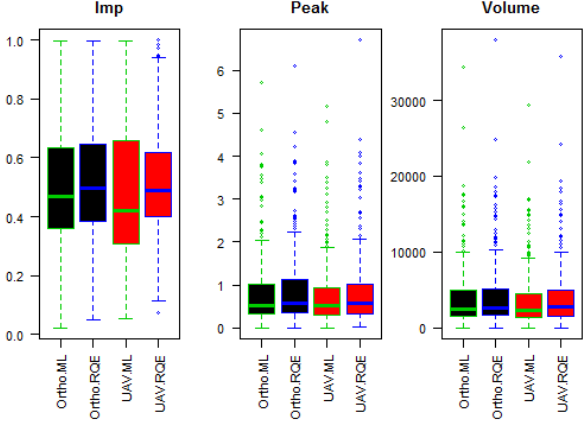
Figure 6. Boxplots of the imperviousness and surface runoff char- acteristics (Imp (–), Peak (Ls − 1 ), Volume (m 3 )) for the 307 sub- catchments for the four combinations of data sources and processing methods. Black = Ortho, red = UAV, green = ML, and blue = RQE.